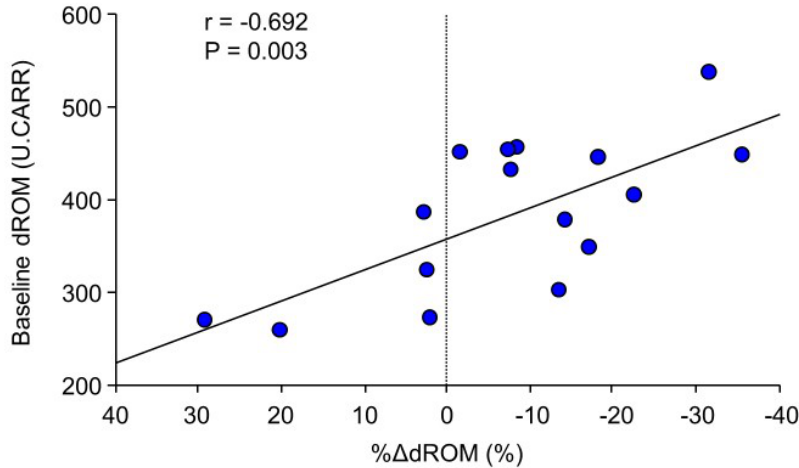
Figure 4. Correlation between the baseline dROM level and the % △ in dROM level from baseline to 3 months. The greater the baseline dROM level, the greater the reduction in dROM level.Abbreviations: dROM, Diacron reactive oxygen metabolites.